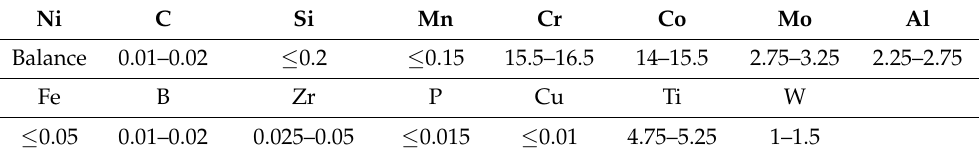
Table 1. Chemical content of investigated GH4720Li (in